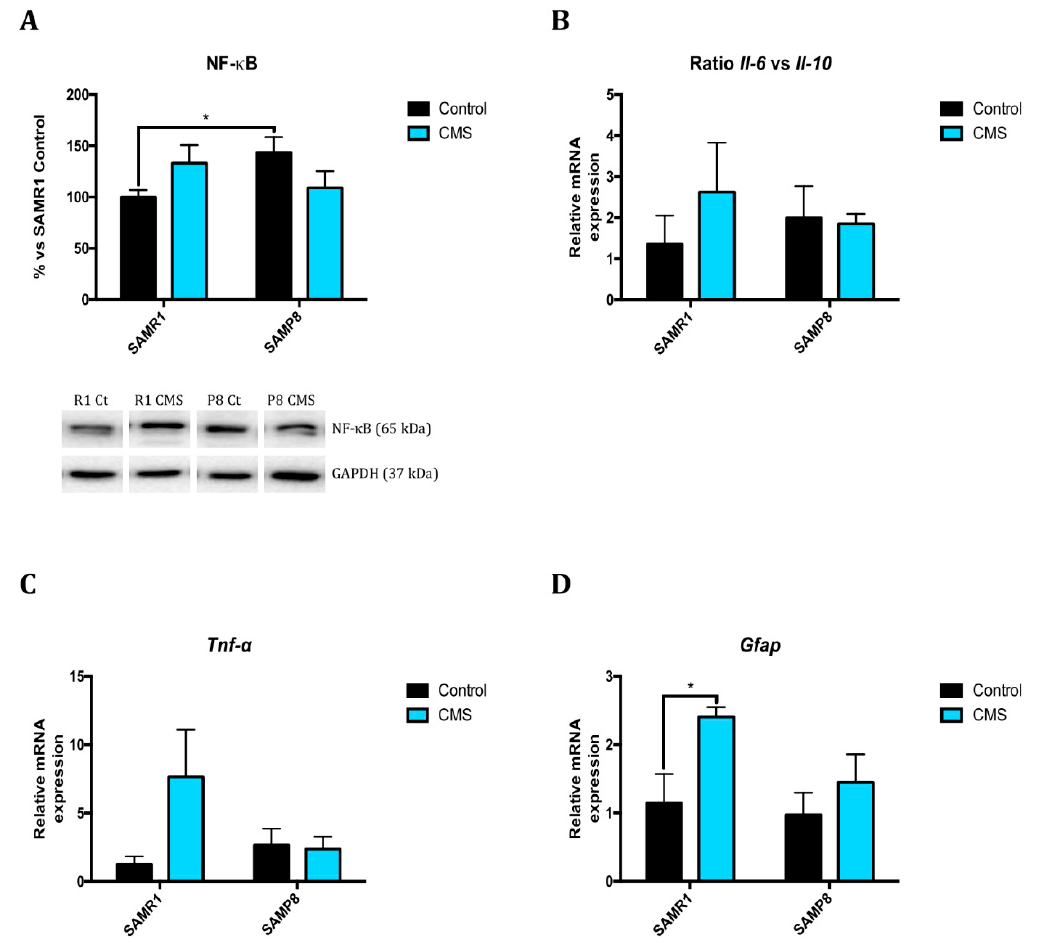
Figure 4. CMS induced changes in inflammatory markers. Representative Western Blot for NF- κ B protein levels and quantification ( A ). Relative gene expression of Il-6 / Il-10 ratio, Tnf- α and Gfap ( B – D ). Values in bar graphs are adjusted to 100% for protein levels of SAMR1 control (R1 Ct). Gene expression levels were determined by real-time PCR. Values are mean ± Standard error of the mean (SEM); ( n = 4 for each group). * p < 0.05.